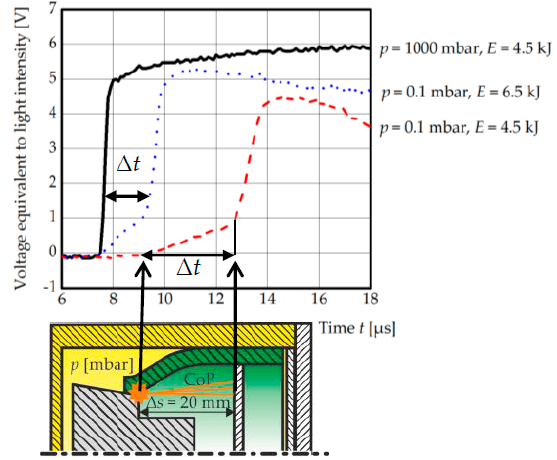
Figure 15. Light intensities for different surrounding pressures p and charging energies at the Bmax setup ( t refers to the rising tool coil current as depicted in the schematic oscilloscope in Figure 1, l c = 3 mm, α = 0° , g = 1.5 mm, Ø coil = 41 mm, w c = 10 mm, l w = 6 mm).